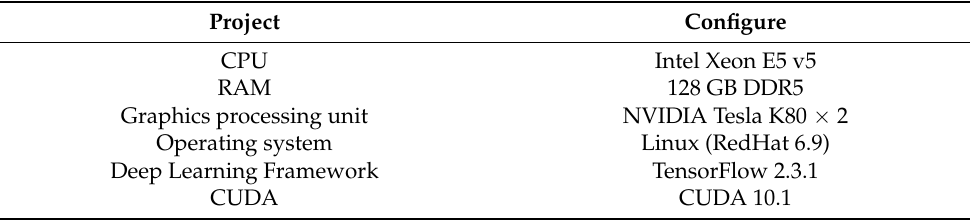
Table 4. GPU node hardware and software details.